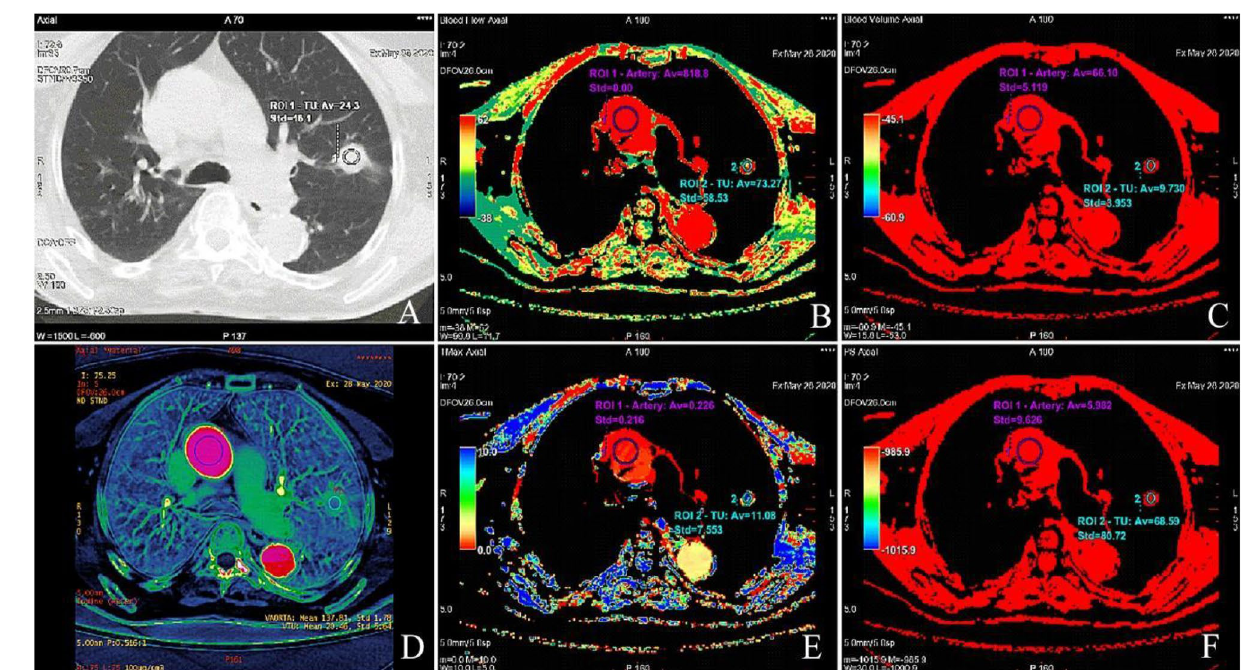
Figure 4. ( A ) CT scan displaying a circular ROI manually placed on the TU with average value of 24.3 HU. ( B ) BF 73.27 ml/100 g/min presents the mean flow rate through vasculature in the ROI tissue region of the TU. ROI 1 (purple color) represents the aorta, ROI 2 (green) denotes the tumor cross-section. ( C ) BV 9.73 ml/100 g presents the mean volume of flowing blood within a vasculature of the tissue region. ( D ) Contrast